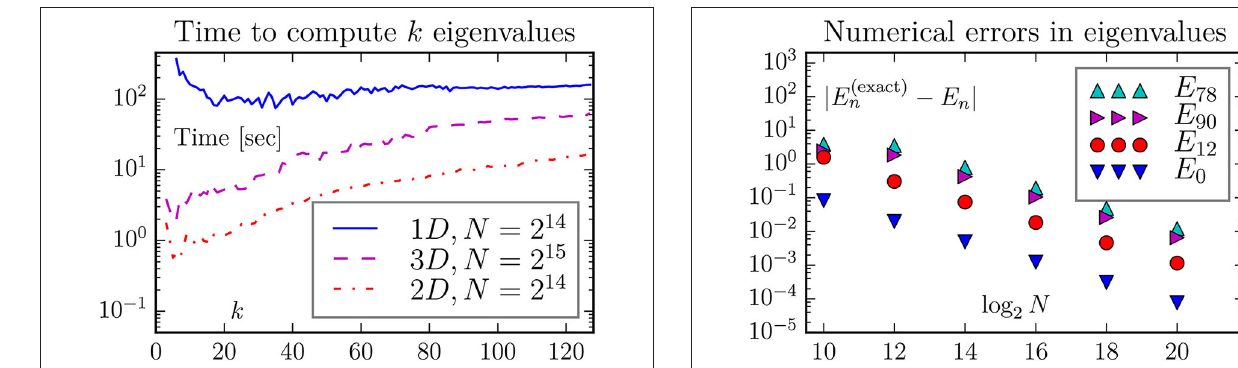
FIGURE 5 | One may think that it takes longer to compute more eigenvalues. This is not always the case when the number of eigenvalues is small, as demonstrated by this figure. The default choice of eigsh is to compute k eigenvalues. For our two- and three-dimensional problems this looks close to the optimal value, but it is too low for the one-dimensional problem.